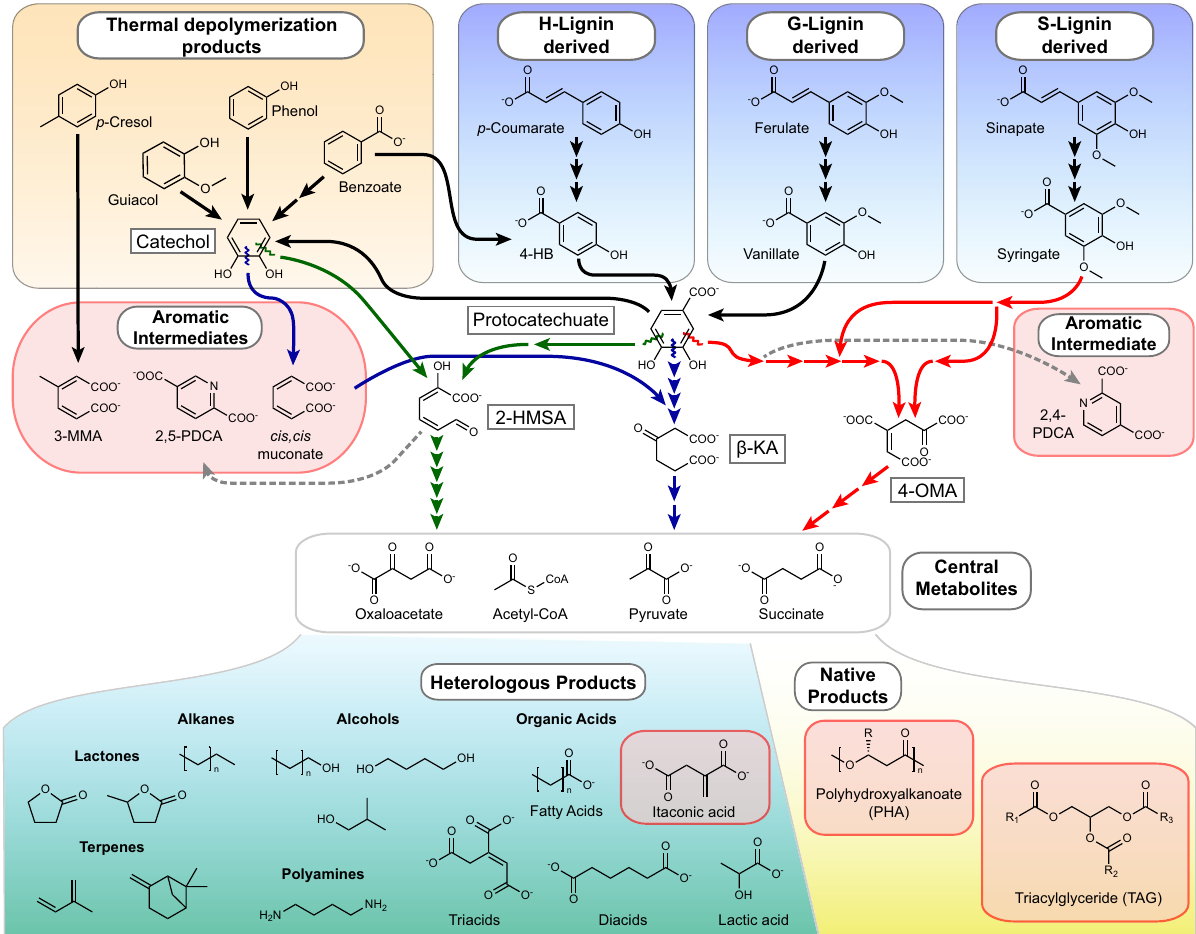
Fig. 1 Biological upgrading of lignin by funneling depolymerized lignin aromatics toward value added products up and downstream of central metabolism. Solid colored and black arrows indicate known metabolic pathway steps for conversion of aromatic intermediates into central metabolites, with dotted black arrows indicating predicted metabolic pathway steps. Dotted gray lines indicate heterologous pathways to convert aromatic intermediates to value-added aromatic derivatives. Red boxed compounds are those whose production from deconstructed lignin have been demonstrated, including itaconate from this study. Acronyms used above: 4-HB (4-hydroxybenzoate), 3-MMA (3-methylmuconate), 2,5-PDCA (2,5-pyridinedicarboxylate), 2,4- PDCA (2,4-pyridinedicarboxylate), β -KA ( β -ketoadipate), 2-HMSA (2-hydroxymuconate semialdehyde), 4-OMA